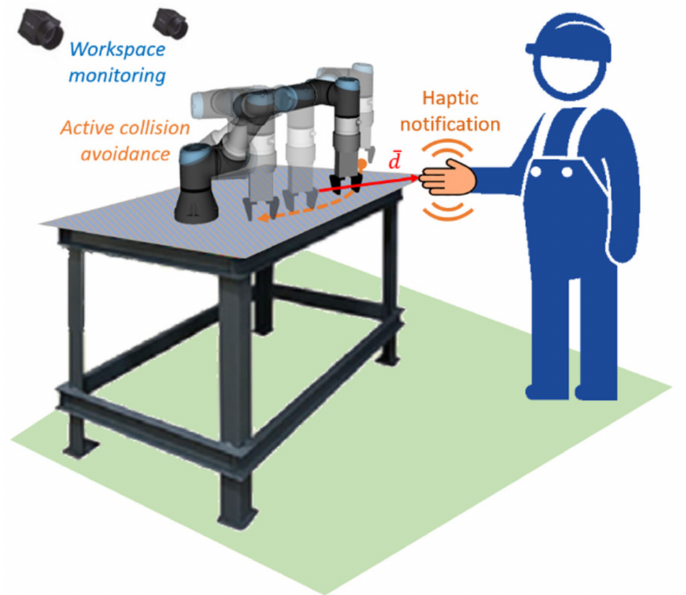
Figure 4. The concept of improved HRC combines principles of active collision avoidance with an increased awareness provided by the wearable haptic feedback device.